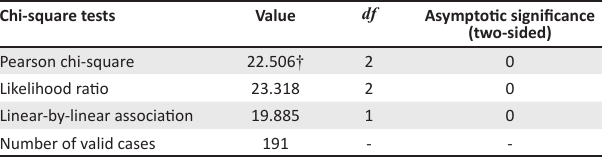
TABLE 3: The relationship between poor saccadic (accuracy) eye movements and the learning disabled.